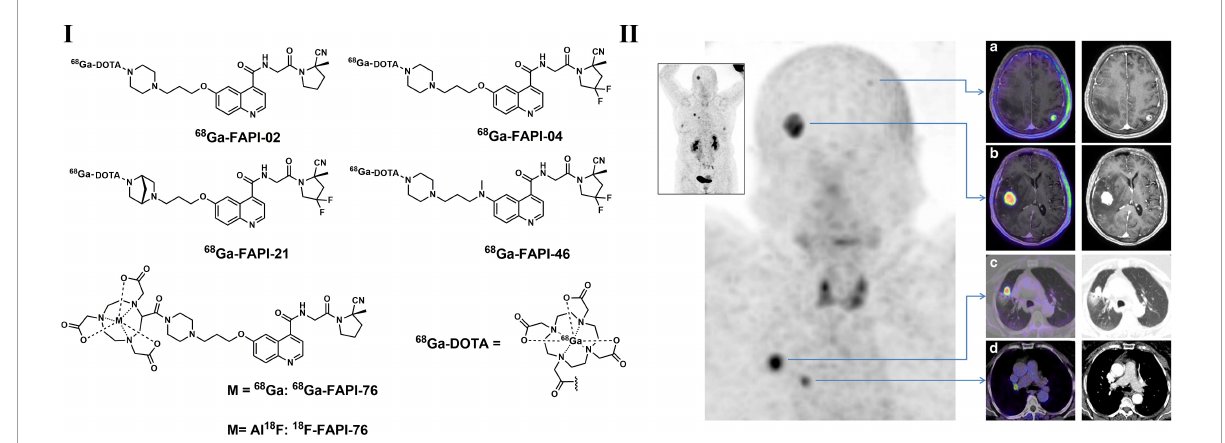
FIGURE6 Structures of typical radiolabeled FAP inhibitors (I) and PET/CT images of 68 Ga-FAPI-04 (a–d) in a lung cancer patient with brain metastasis (II) .